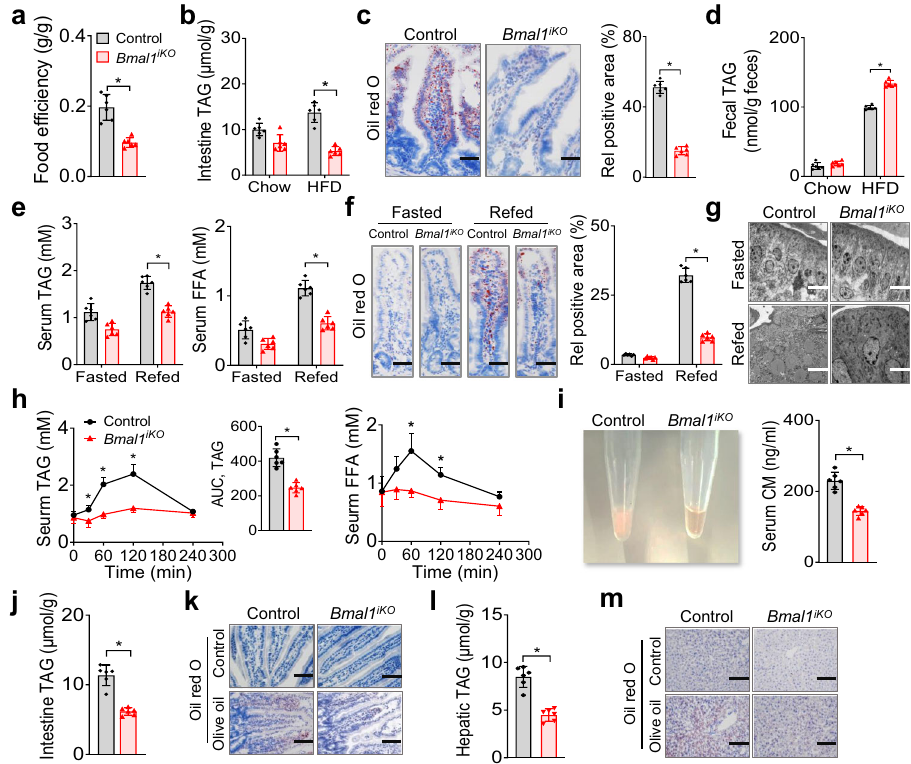
Fig. 2 Decreased dietary fat absorption in Bmal1 iKO mice. a Food ef fi ciency of Bmal1 iKO and control mice during 10 weeks feeding on HFD. b Intestinal TAG levels in Bmal1 iKO and control mice after 10 weeks feeding on chow or HFD. c Oil red O staining of proximal small intestine from Bmal1 iKO and control mice after 10 weeks feeding on HFD. Scale bar, 50 μ m. d Fecal TAG levels in Bmal1 iKO and control mice after 10 weeks feeding on chow or HFD. e Serum TAG and FFA levels in fasted and refed Bmal1 iKO and control mice. Mice were fasted for 12 h followed by HFD re-feeding for 1 h. f Oil red O staining of proximal small intestine from fasted and refed Bmal1 iKO and control mice. Mice were treated as in e . Scale bar, 50 μ m. g Electron microscopic images of proximal small intestine from fasted and refed Bmal1 iKO and control mice. Scale bar, 5 μ m. h Serum TAG (left) and FFA (right) levels in Bmal1 iKO and control mice after oral gavage of olive oil (10 μ l/g). The insert shows the AUC (area under the curve) values for serum TAG. i Image of serum samples (left) and measurements of serum CM (right). Samples were derived from Bmal1 iKO and control mice at 2 h after oral gavage of olive oil (10 μ l/g). j Intestinal TAG levels in Bmal1 iKO and control mice at 2 h after oral gavage of olive oil. k Oil red O staining of proximal small intestine from Bmal1 iKO and control mice at 2 h after oral gavage of olive oil. Scale bar, 100 μ m. l Hepatic TAG levels in Bmal1 iKO and control mice at 2 h after oral gavage of olive oil. m Oil red O staining of livers from Bmal1 iKO and control mice at 2 h after oral gavage of olive oil. Scale bar, 100 μ m. All data points are mean ± SD ( n = 6 biologically independent samples). For c (left), f (left), g , k and m , similar results were obtained in six independent experiments. *represents a p value of < 0.05 (two-sided t test or two-way ANOVA with Bonferroni post hoc test). CM,